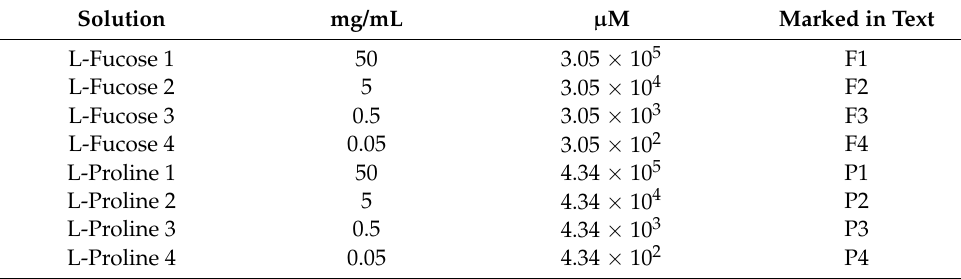
Table 1. The concentrations of L-fucose and L-proline